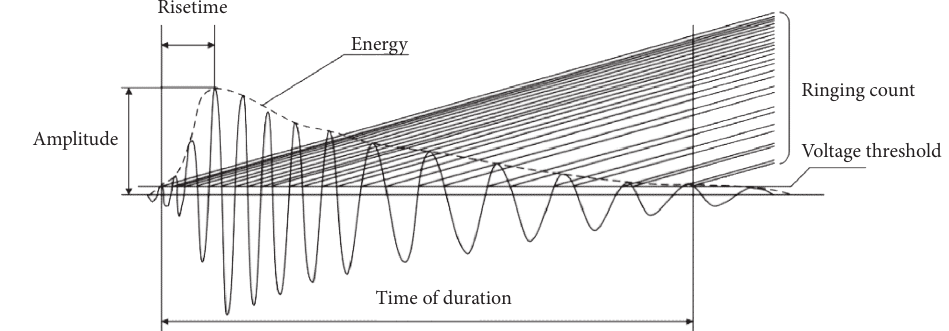
Figure 7: Diagram of waveform parameters in acoustic emission signal.